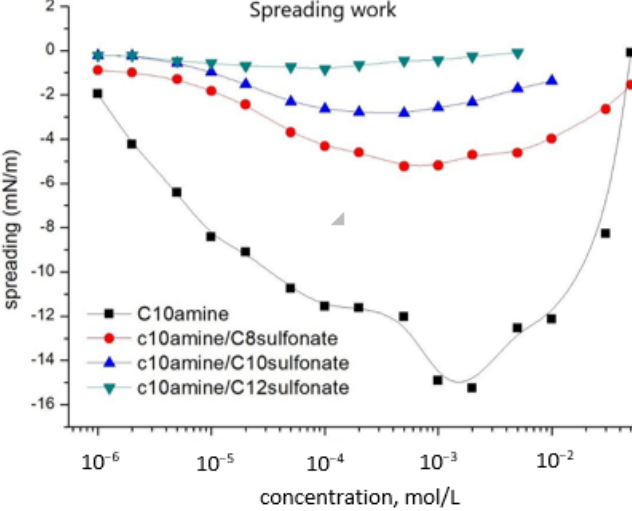
Figure 10. Spreading vs. concentration for different systems.